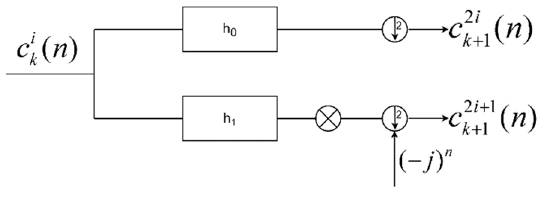
Figure 3. Low-pass and high-pass filter decomposition.